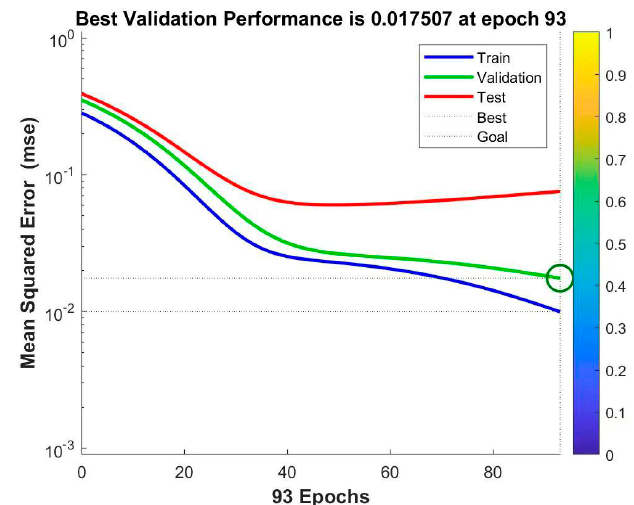
Figure 3. Output iterative precision curve.